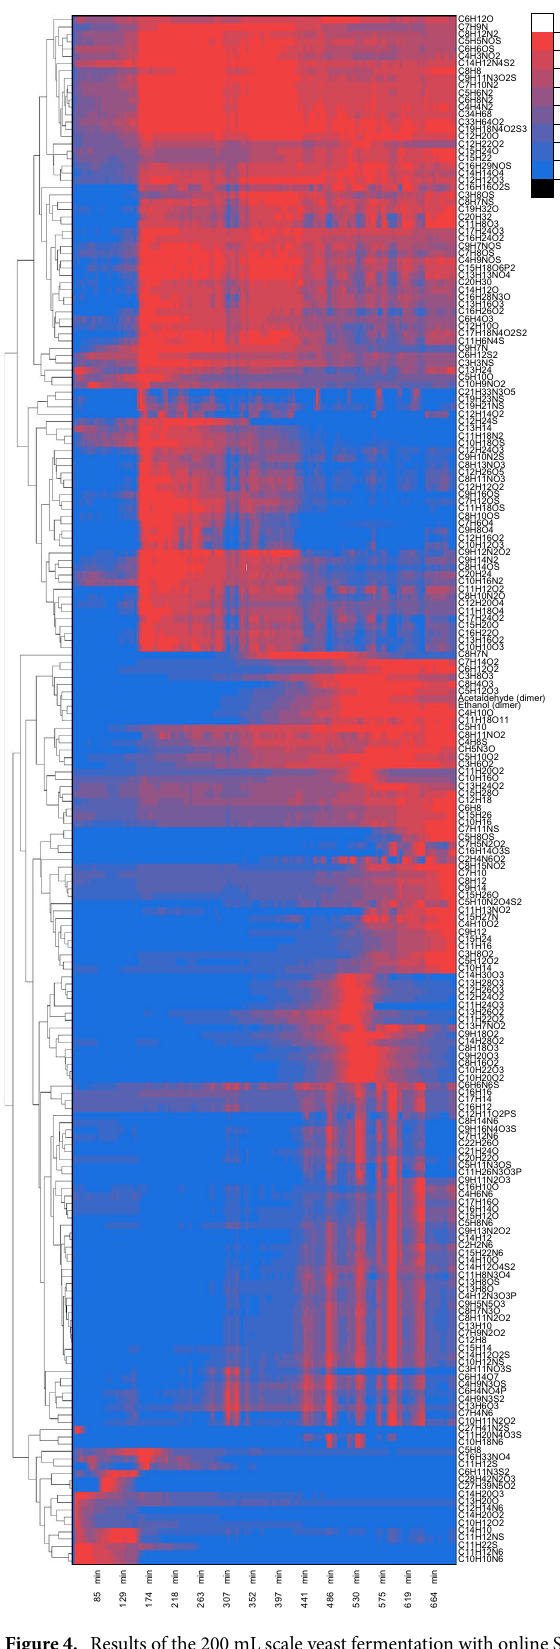
Figure 4. Results of the 200 mL scale yeast fermentation with online SESI-Orbitrap MS-based off-gas analytics. Heatmap of all tentatively identified metabolites measured throughout the experiment, clustered, and normalised to their individual maximum (blue to red, low to high intensity), every pixel shown is the mean of 100 scans, the first pixel represents the mean of the 30 min